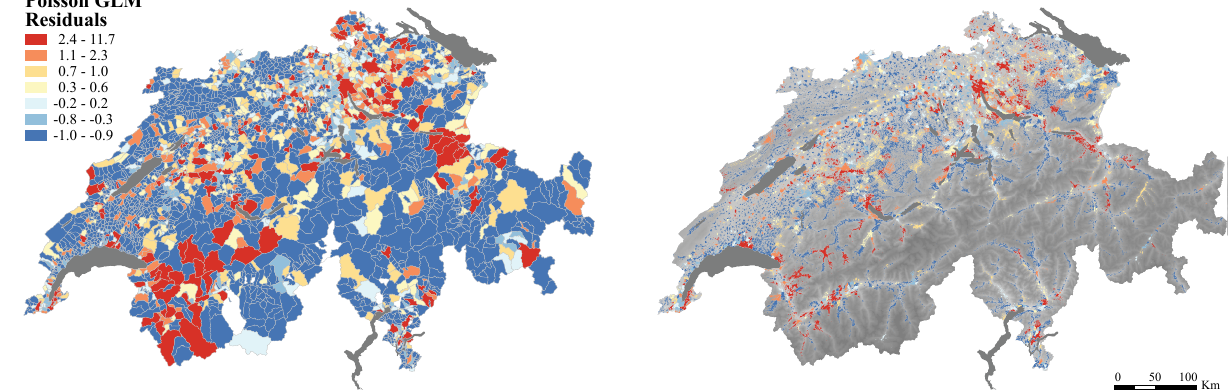
Figure 1. Dog tumor incidence count model residuals represented through municipality-level unrefined units (left) and dasymetrically refined units (right) (data: SFOT, 2015)